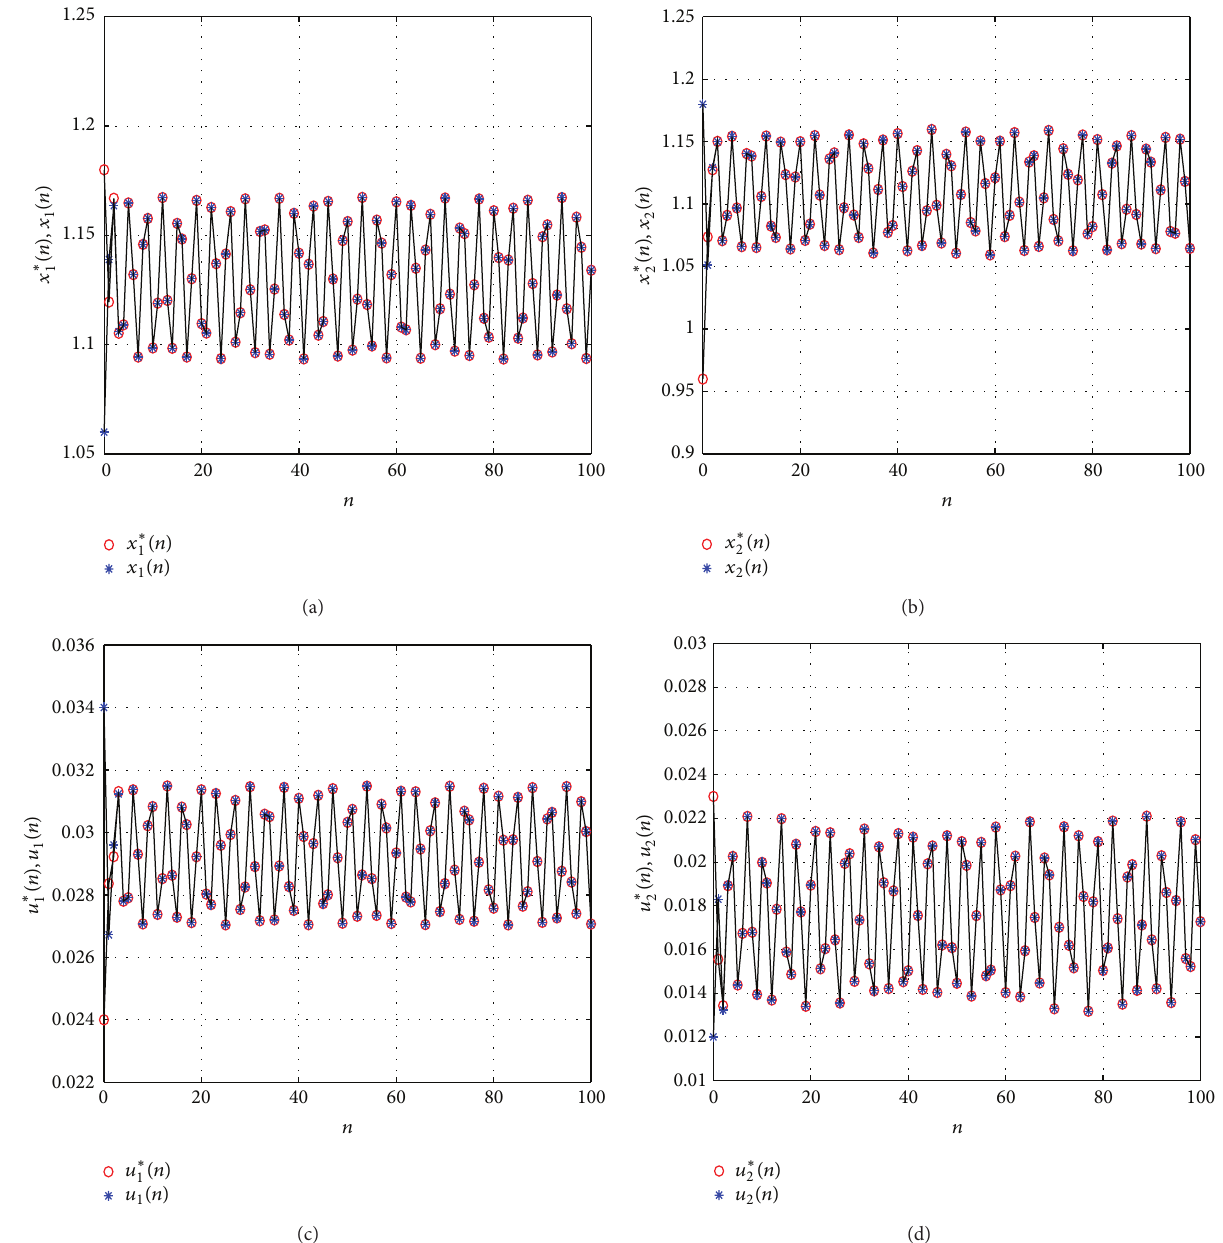
(𝑛),𝑥 (𝑛),𝑢 (𝑛) , and 𝑢 (𝑛) with initial values 𝑥 1 2 1 2